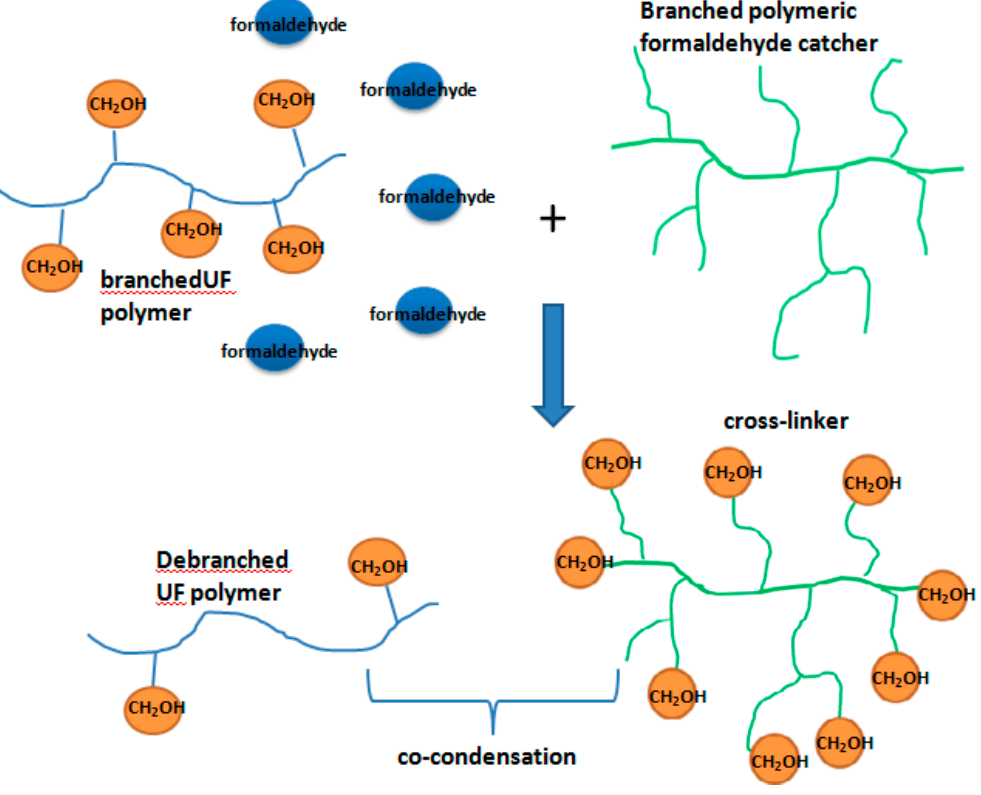
Figure 13. The proposed branched polymeric formaldehyde catcher.